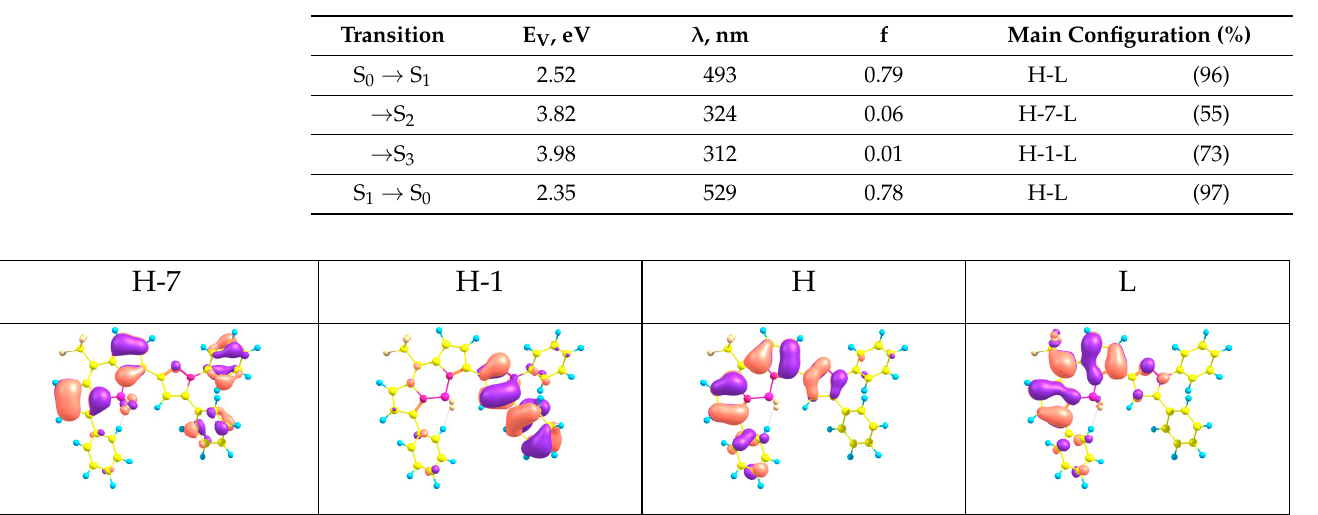
Table 2. Energies, oscillator strengths, and dominant molecular orbital configurations of vertical calculated at the TD-CAM-B3LYP level of theory.